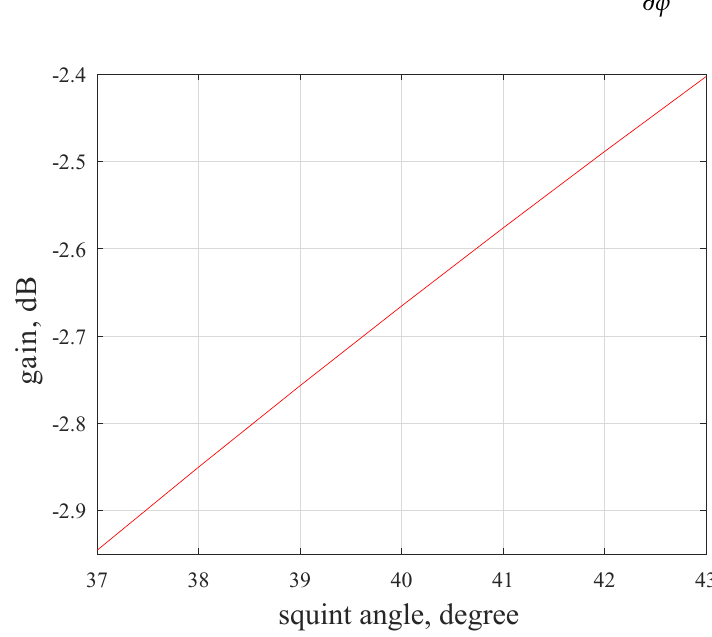
Figure 4. The squint angle dependence of the EAP at the swath